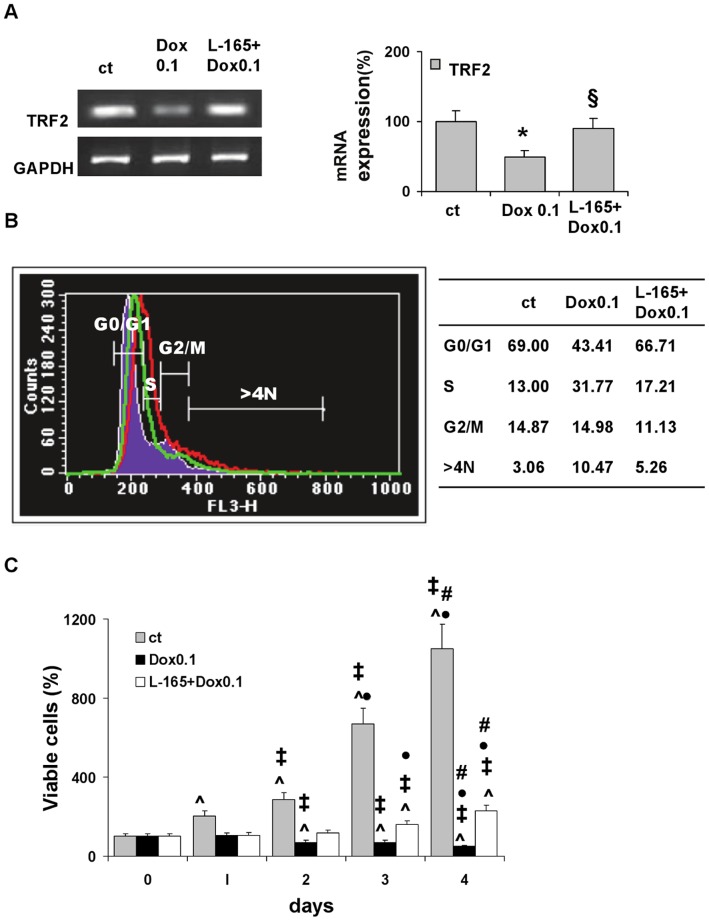
L-165041 prevents doxorubicin-induced changes in neonatal rat cardiomyocytes.Incubation for 3 h with low dose doxorubicin 0.1 µM (Dox 0.1) modifies the expression levels of telomere binding factor 2 (TRF2), the cell cycle and cell viability. Pre-treatment for 2 h with L-165041 (L-165) prevents doxorubicin-induced modifications. (A) TRF2 mRNA evaluated 4 h after doxorubicin treatment. *p<0.05 versus control (ct), §p<0.05 versus Dox 0.1. (B) FACS analysis of cell cycle distribution 24 h after treatment with Dox 0.1. Filled line: untreated cells; red line: cells treated with Dox 0.1; green line: cells pre-treated with L-165041 and then treated with Dox 0.1. Percentages of cell subpopulations are summarized in the Table. (C) Cell viability determined by MTT Assay. ˆp<0.05 versus day 0. ‡p<0.05 versus day 1. • p<0.05 versus day 2. # p<0.05 versus day 3.